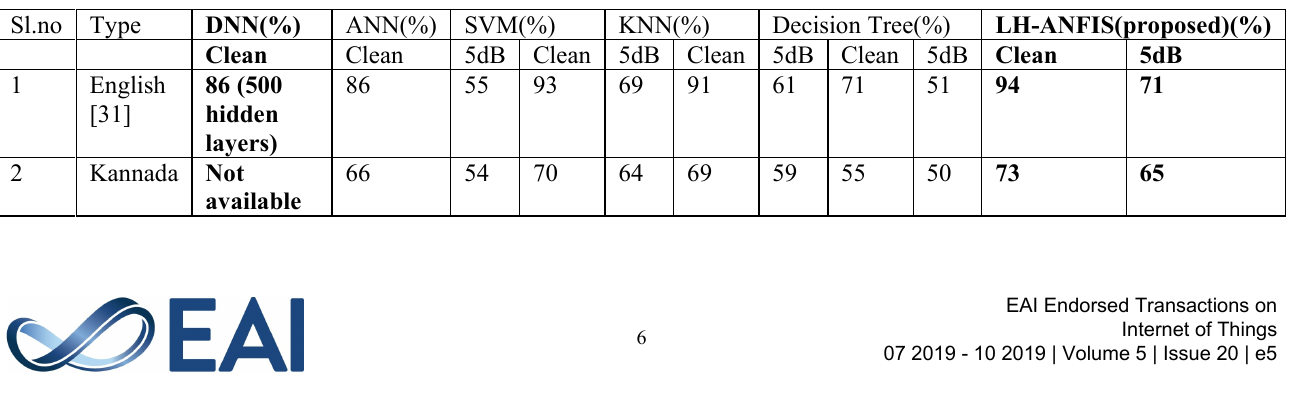
Table 5. Recognition